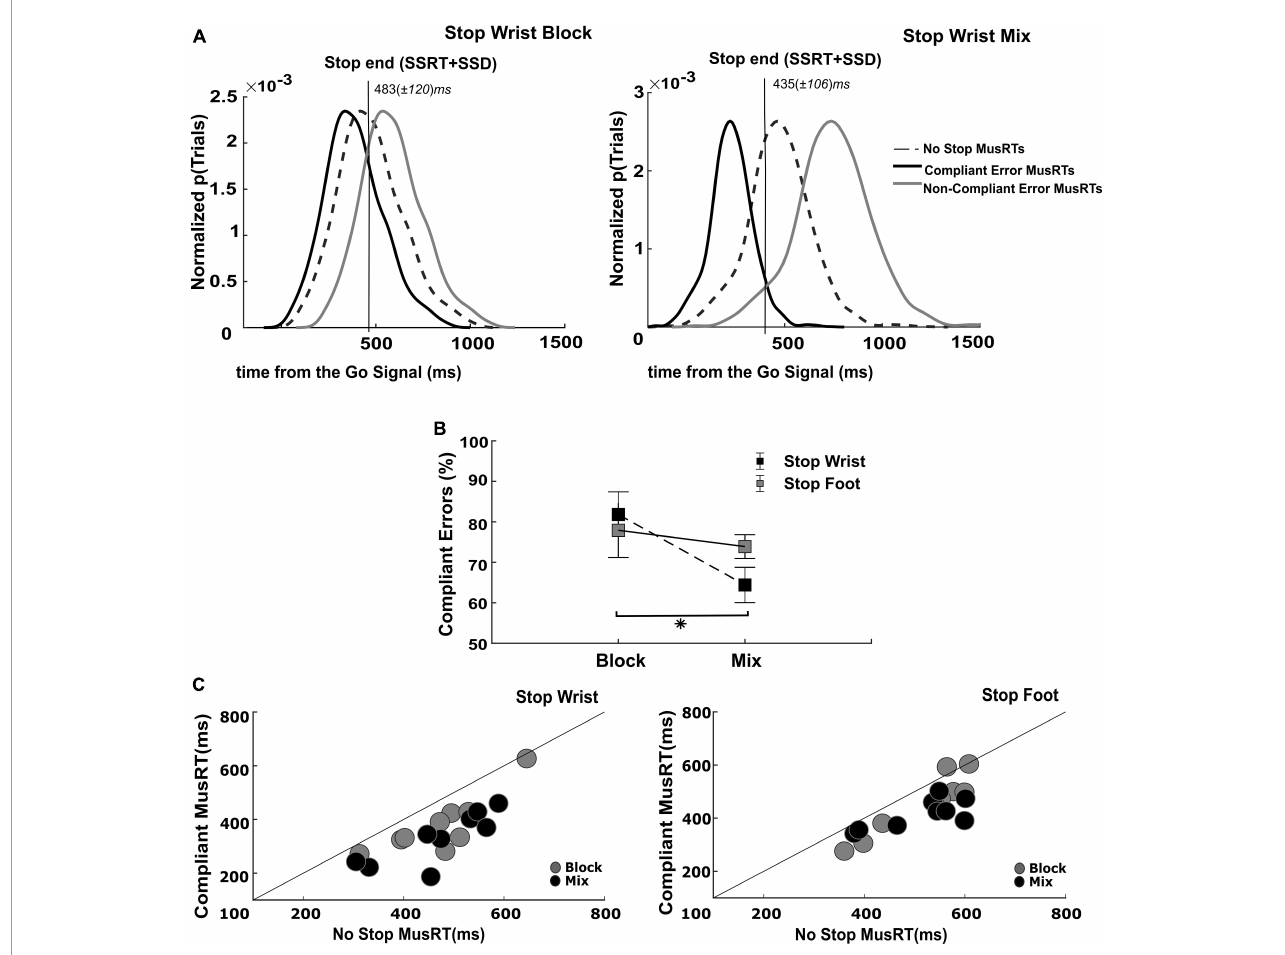
FIGURE5 Evaluation of assumption of context independence in Compliant Stop Error trials. (A) Identification of Compliant and Non-Compliant Stop Error MusRTs; (B) proportion of Compliant Error trials in each Stop version and task condition ( ∗ p < 0.05); error bars indicate S.E.M. (C) Testing of assumption of independence in Compliant Stop Error